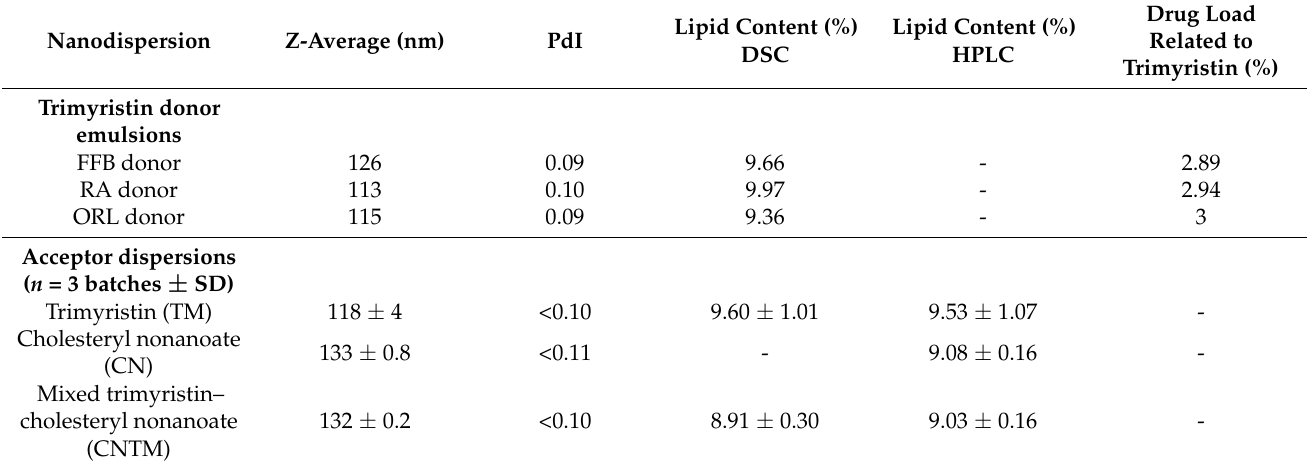
Table 1. Particle sizes, lipid content, and drug load of the different nanodispersions used as donors in transfer studies or as acceptor particles to be incorporated into the hydrogel